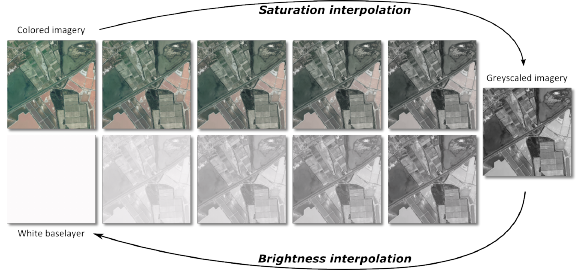
Figure 11: Baselayer interpolation process.